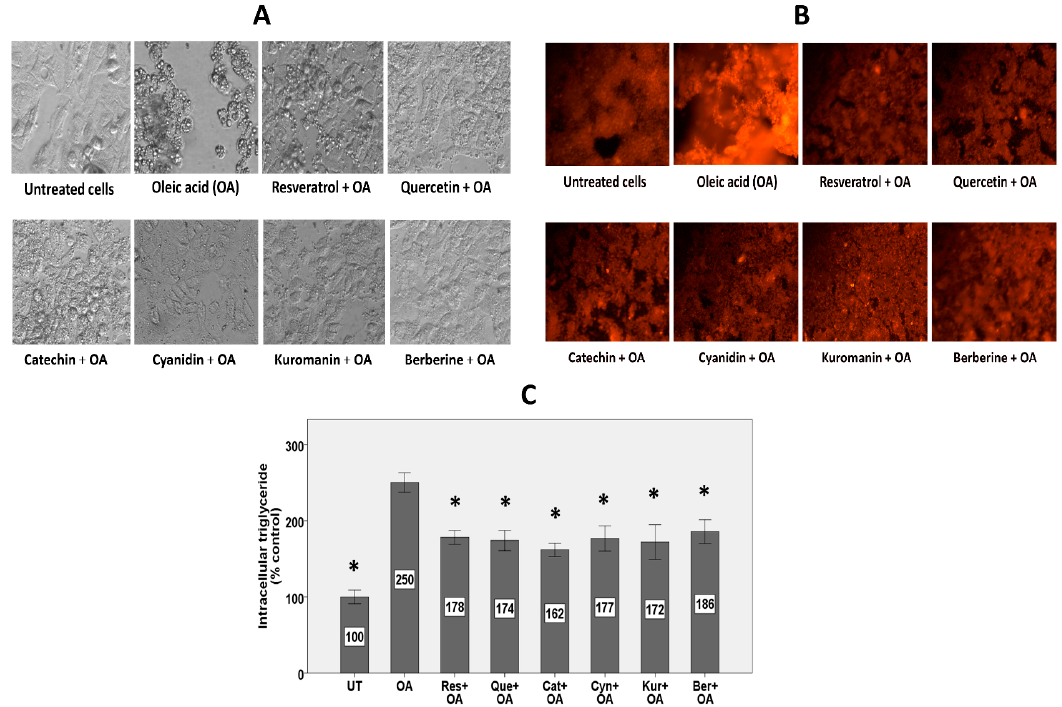
Figure 1. The effect of polyphenols on OA-induced steatosis. HepG2 cells were treated with 10 µ M polyphenols for 2 h followed by treatment with 1.5 mM OA for 24 h in the presence of the polyphenols. ( A ) Brightfield images with a 40 × objective lens showing morphology of hepatocytes ( B ) Fluorescence images with a 40 × objective lens using Nile Red fluorescence probe showing intracellular lipid content. ( C ) Intracellular lipid after quantification of Nile Red fluorescence using a microplate reader. Lipid levels were normalized to protein level in each treatment group as determined by the bicinchoninic acid (BCA) protein assay. Untreated cells were set at 100% and data are presented as % of the untreated cells. The Figure represents means ± SEM of three independent experiments with three wells of cells in each experiment. UT: untreated, OA: oleic acid, Res: resveratrol, Que: quercetin, Cat: catechin, Cyn: cyanidin, Kur: kuromanin, Ber: berberine. The data were analyzed by one-way ANOVA with Dunnett’s post-hoc comparison to the OA alone condition. (*) Significantly different from the OA alone condition at p < 0.05.